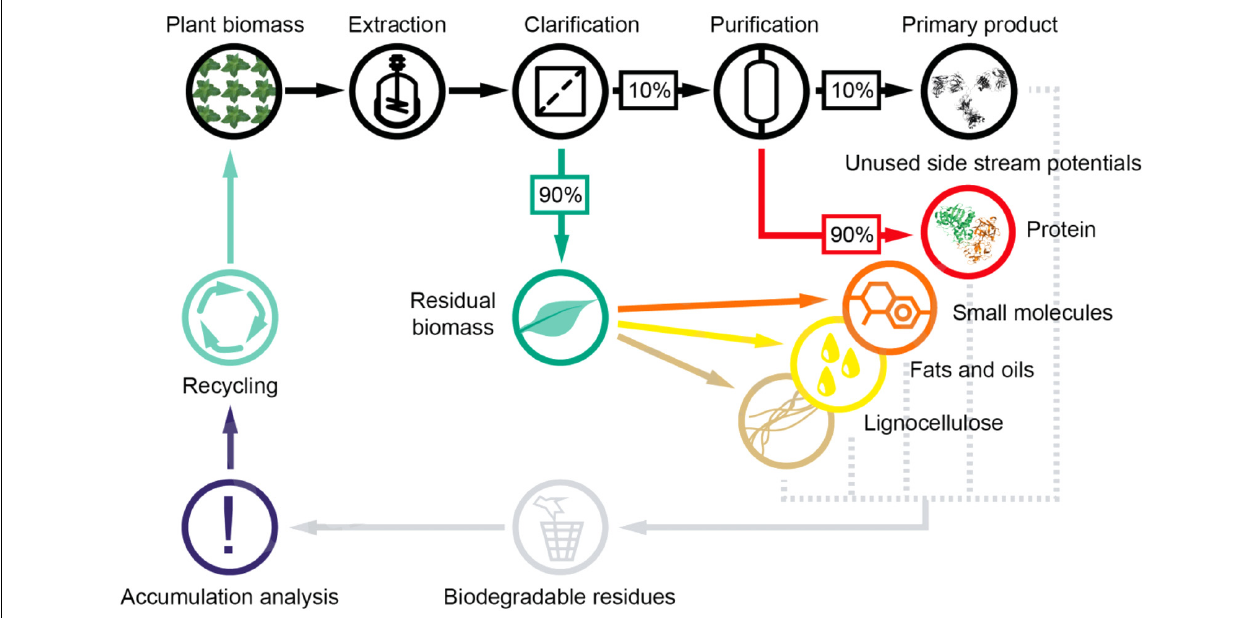
FIGURE 3 | Potential product side streams in plant molecular farming. Most often the primary product constitutes less than 1% of the biomass produced during upstream processing. Opportunities arise for additional revenue when biomass side streams, especially proteins and small molecules, are included in the valorization, which broadens the diversity of the value chain. An integration with existing facilities, e.g., biogas plants, may be required for a cost-effective processing of side products with low